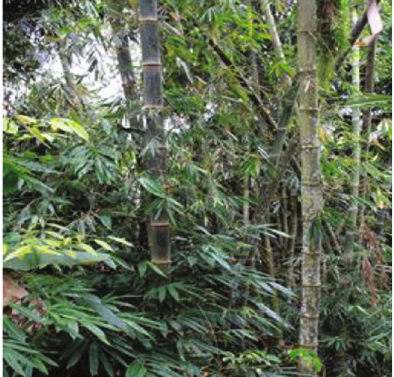
Figure 3: Dendrocalamus asper (Schult.)